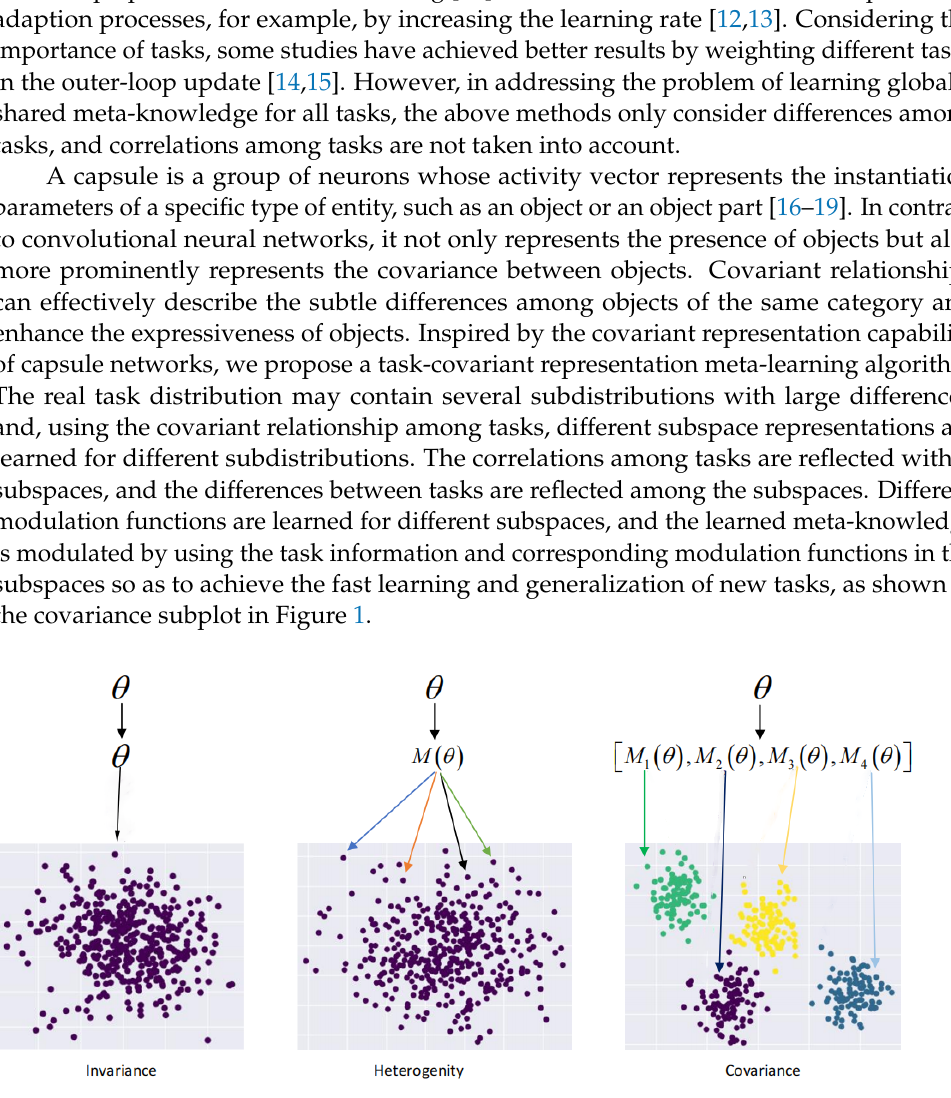
Figure 1. Task-invariant, task-heterogeneous, and task-covariant representation meta-learning com- parison diagram. Task-invariant representation meta-learning learns globally shared meta-knowledge for all tasks, task-heterogeneous meta-learning uses task information to adaptively modulate learned meta-knowledge, and task-covariant representation means that meta-learning uses the covariant relationships among tasks to assign the current task to the corresponding subspace and uses the modulation function and task information corresponding to the subspace to adaptively modulate the learned